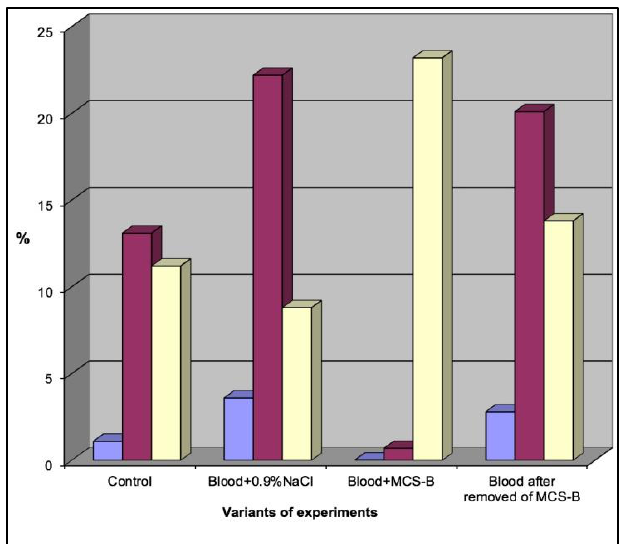
Figure 1: Dynamic indicators of platelet aggregation in different variants of the experiment (n=14). MCS-B: magnet- controlled